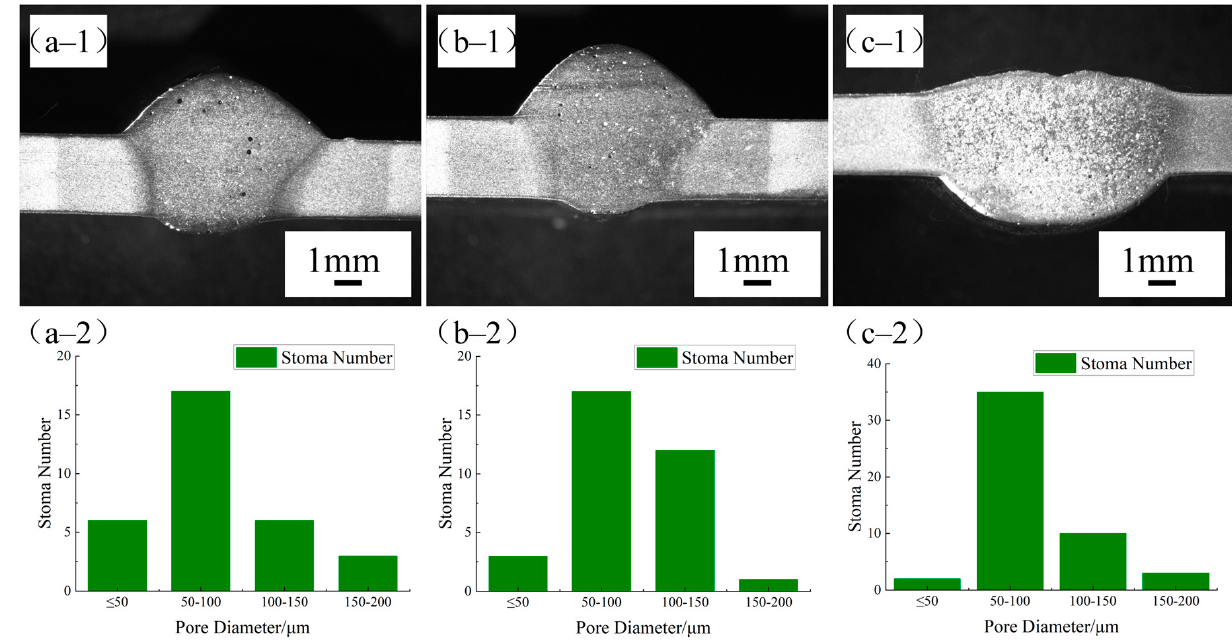
Figure 5. Different welding current under the welded joint cross-sectional morphology and the number and size of pores: ( a-1 ) 90 A; ( b-1 ) 105 A; ( c-1 ) 120 A; ( a-2 ) 90 A; ( b-2 ) 105 A; ( c-2 ) 120 A.